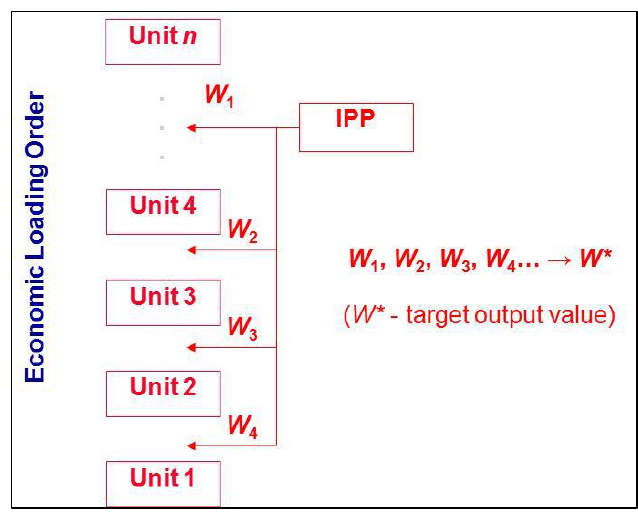
Figure 2. Adjusting the loading order in order to obtain the desired output value for a unit.